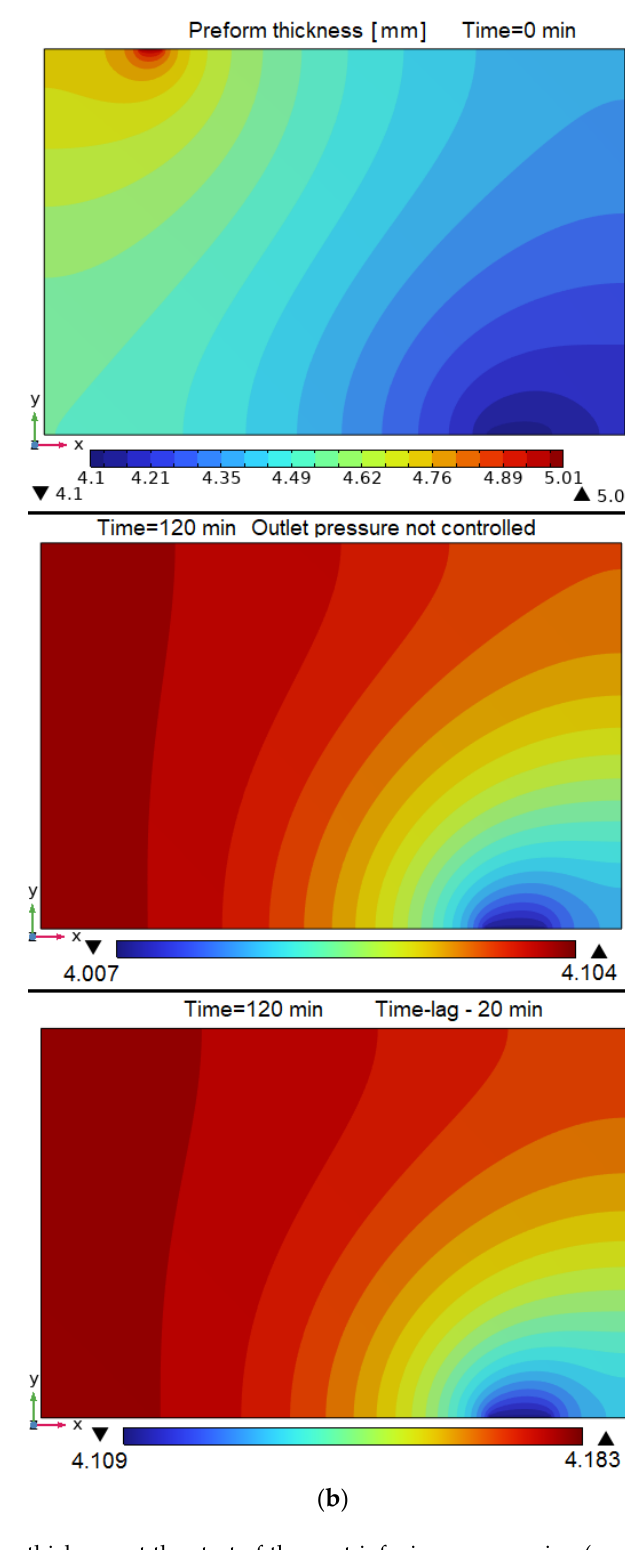
Figure 10. Distribution of preform thickness at the start of the post-infusion compression (upper pictures) and after 2 h of exposure to compressive pressure p appl according to the 1st ( a ) and 2nd ( b ) scenarios. The middle pictures correspond to the case of a constant pressure at the outlet p out = p vac = 20 kPa, whereas the lower pictures correspond to the outlet pressure that began to grow 20 min after the start of the process and reached atmospheric p out = p atm = 100 kPa.